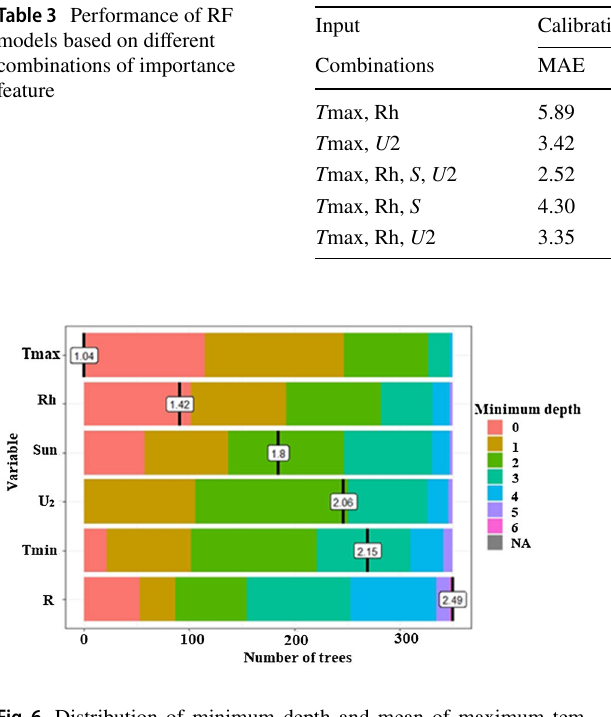
Fig. 6 Distribution of minimum depth and mean of maximum tem- perature (Tmax), relative humidity (Rh), sunshine duration ( S ), wind speed ( U 2 ), minimum temperature ( T min) and rainfall